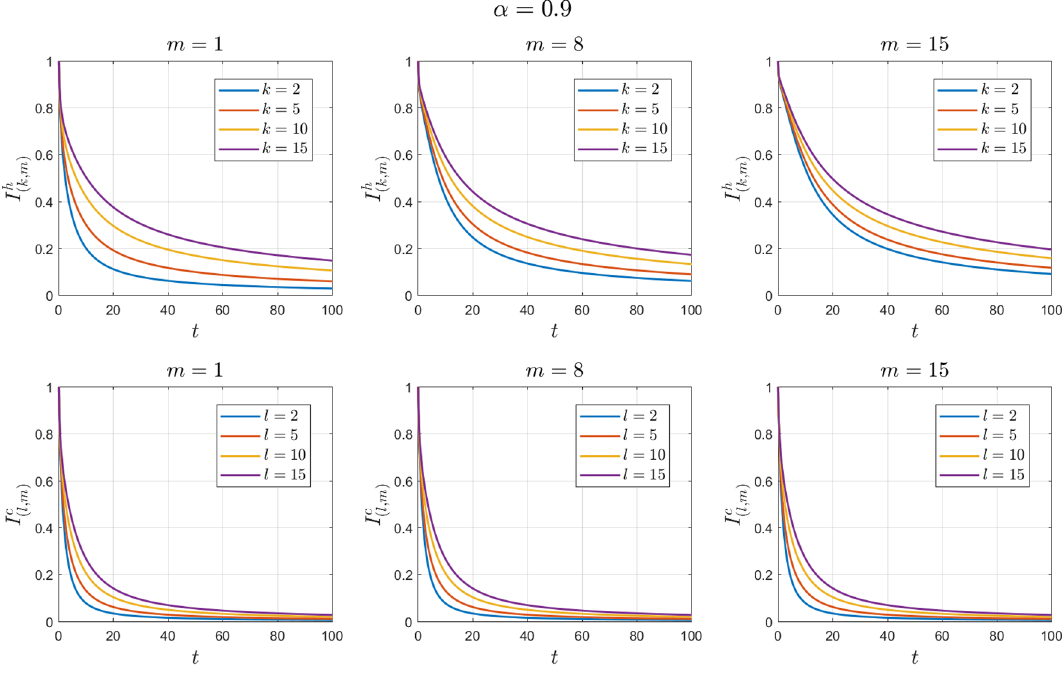
= ( 0 ) , I h ( 0 ) , S c ( 0 ) , I c ( 0 ) S h ( k , m ) ( k , m ) ( l , m ) ( l , m ) (cid:31) (cid:30)